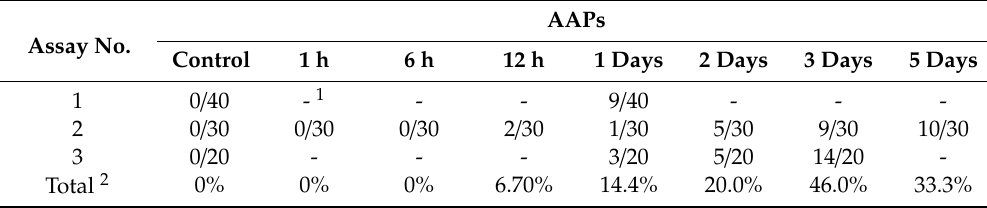
Table 3. Results of CaLsol detection in T. erytreae specimens of each of the acquisition access periods (AAPs) evaluated. Assay No.